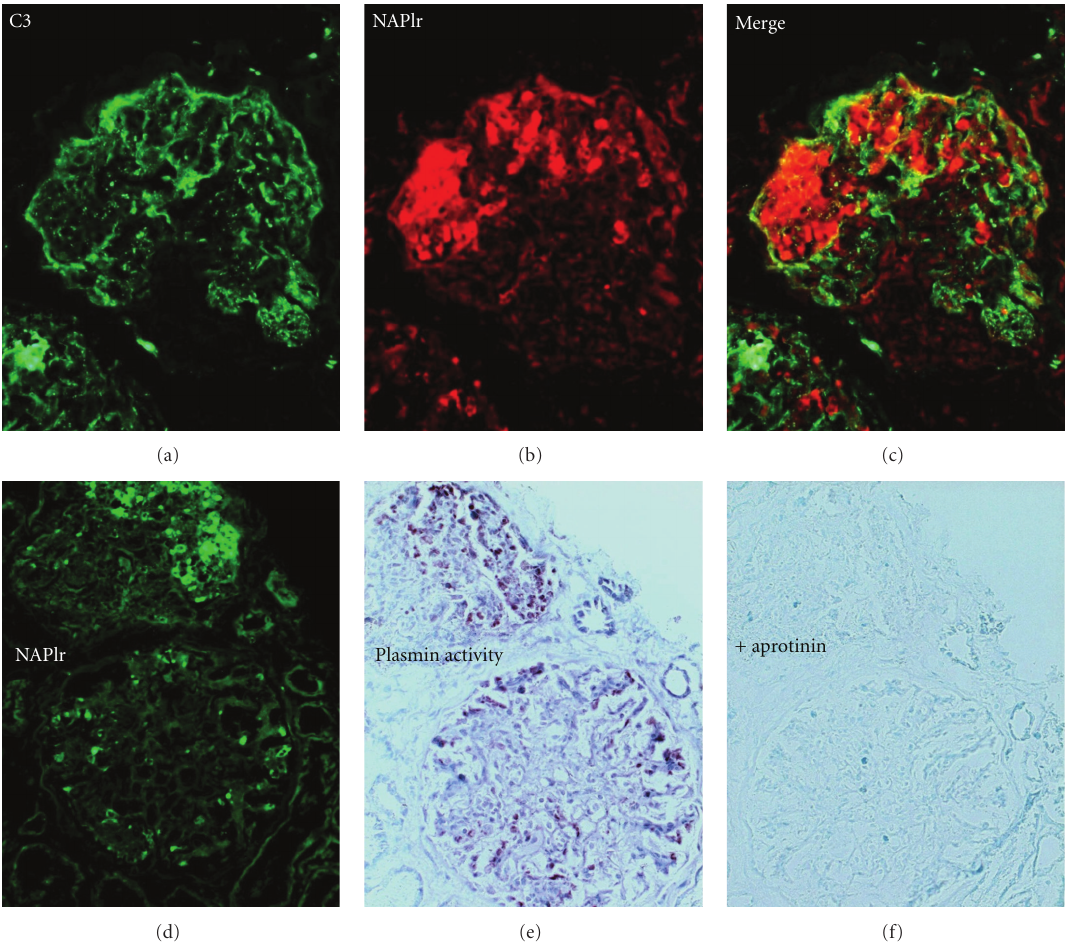
Figure 3: Representative photomicrographs of double immunofluorescence staining for C3 (FITC; green) and NAPlr (Alexa Fluor 594; red) ((a)–(c)). The distributions of C3 (a) and NAPlr (b) were obviously di ff erent in the merged image (c). ((d)–(f)). NAPlr IF staining and in situ zymography for plasmin activity in serial sections of renal biopsy tissue from an APSGN patient. The distribution of plasmin activity was similar to that of NAPlr deposition ((d) and (e)). Addition of aprotinin inhibited the zymographic activity suggesting the activity to be plasmin (f) (original magnification × 200).